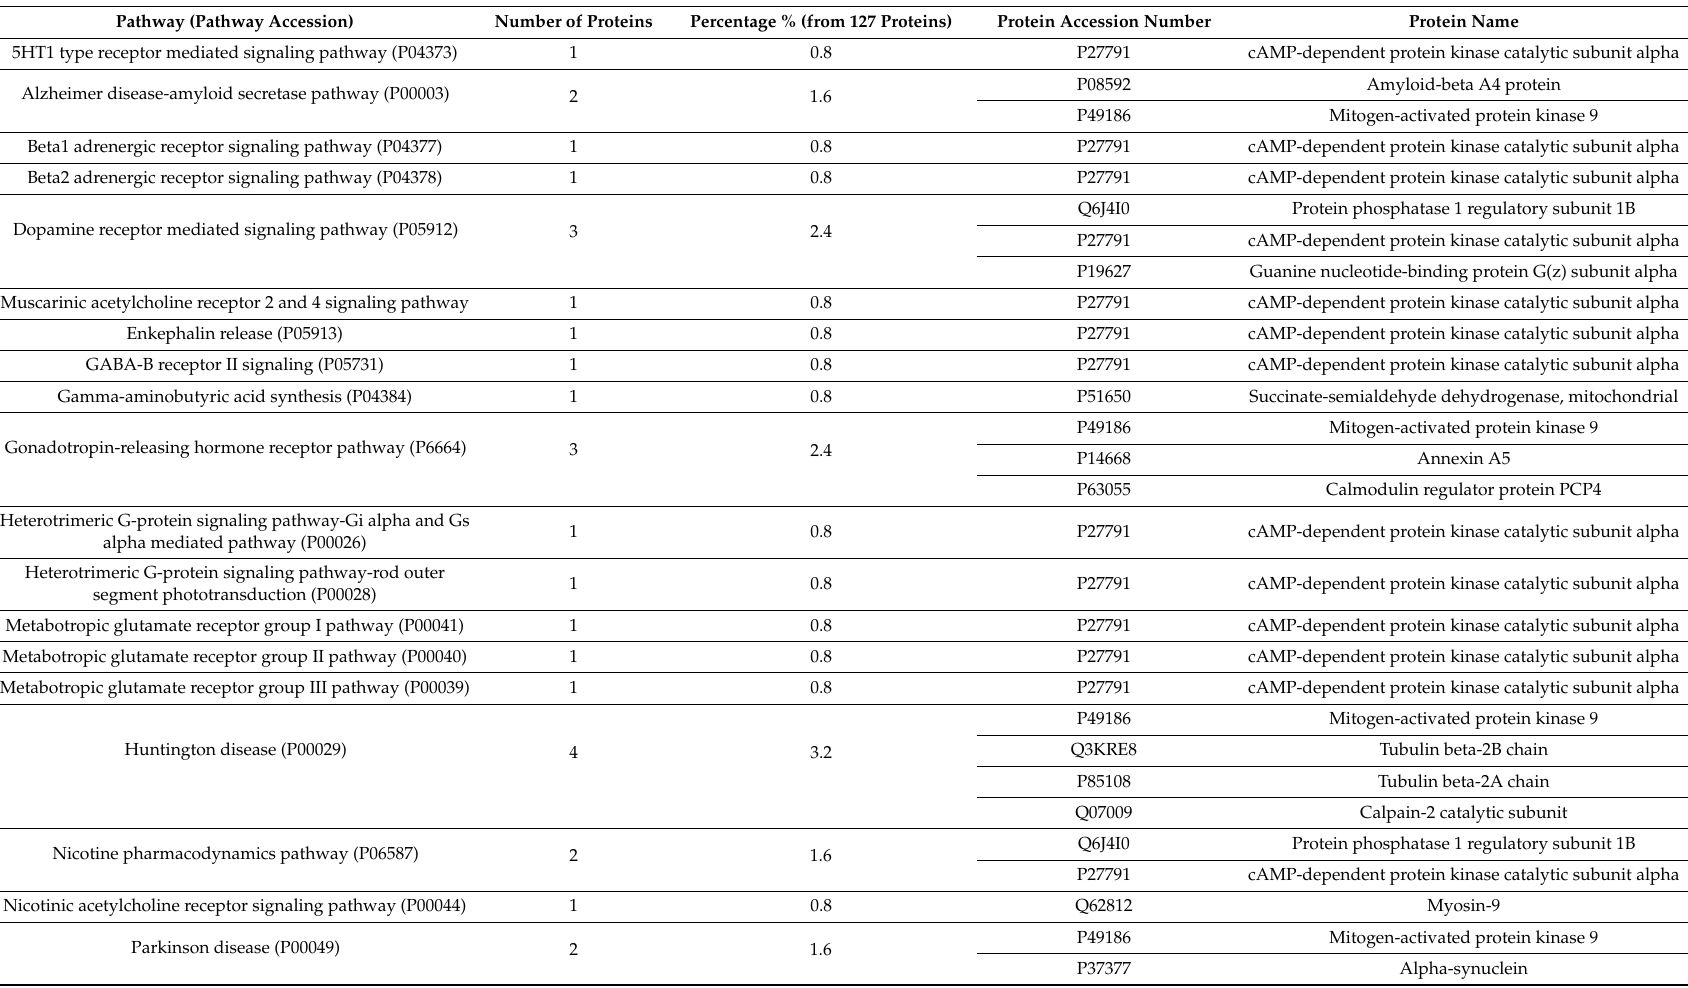
Table 2. Signaling pathways related to the nervous system identified following the dysregulation of cerebral proteins. The data were generated from PANTHER Classification